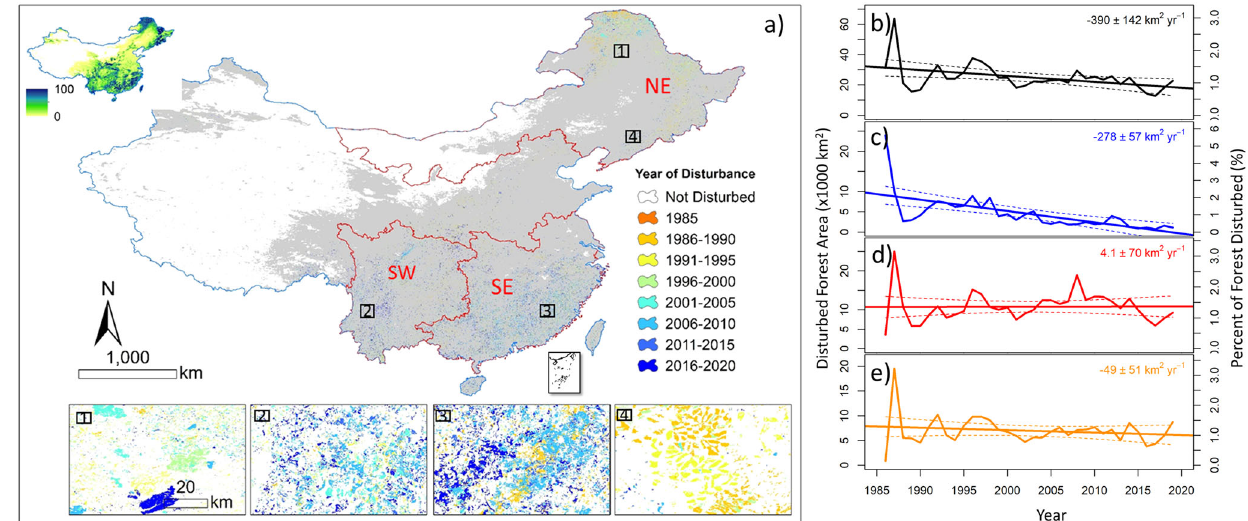
Fig. 1 Forest disturbances in China ’ s forests from 1986 to 2020. a The occurrence of disturbances across China ’ s forests, overlaid on the forested region (TC 1986 > 20%, gray area). Inset in top left showed the TC 1986 (see Methods), and insets 1 – 4 showed disturbances in a few exemplary regions. The Northeast (NE), Southeast (SE), and Southwest (SW) regions were shown in red polygons. Years of disturbance were binned into 5years for illustration purpose. For the annual disturbance map, refer to Data availability section. b – e are annual disturbance area and trends at national (back), NE (blue), SE (red), and SW (dark orange) regions, respectively. In b – e , disturbance area (1000km 2 ) and percent of forest disturbed (%) are shown in left and right Y -axis, respectively. The numbers indicated the trends of annual disturbed area (km 2 yr − 1 ) in different regions. Note the scale differences in b – e .